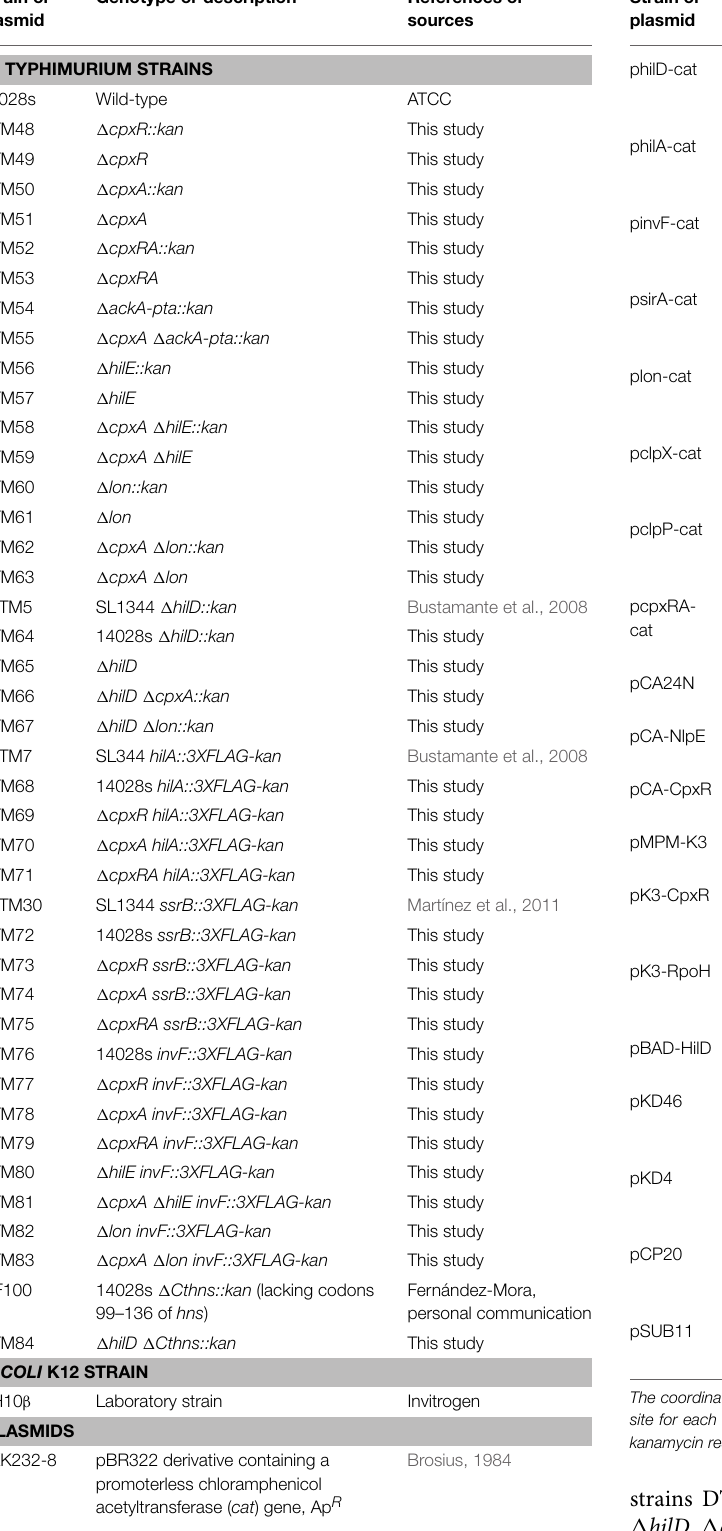
TABLE 1 | Bacterial strains and plasmids used in this study. Strain or